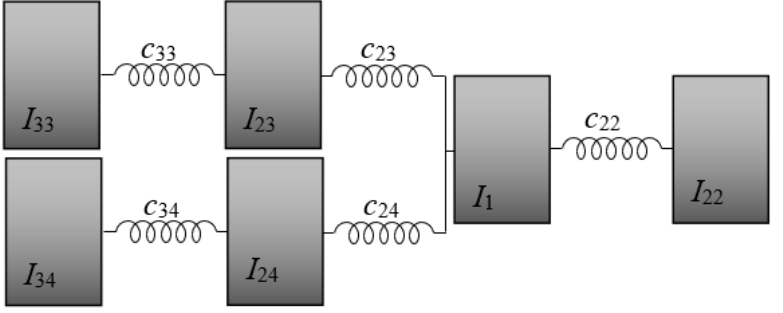
Figure 9. The cascade-branched structure of the drive system.